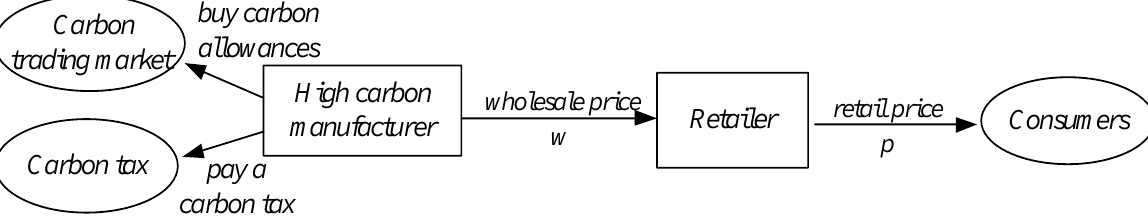
Figure 1. Model structure of the HCSC.